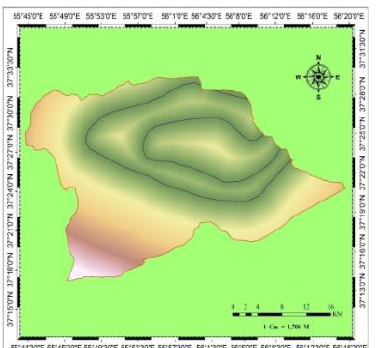
Figure 9. Isothermal lines map in the study